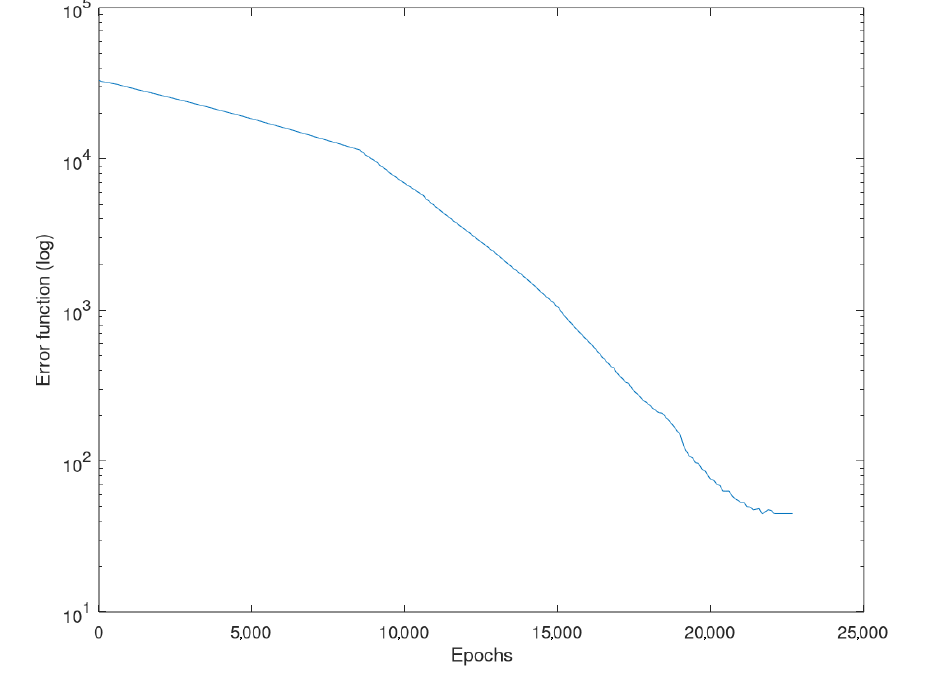
Figure A4. Error function averaged evolution curve for the training on the ultimate tensile strength data (logarithmic